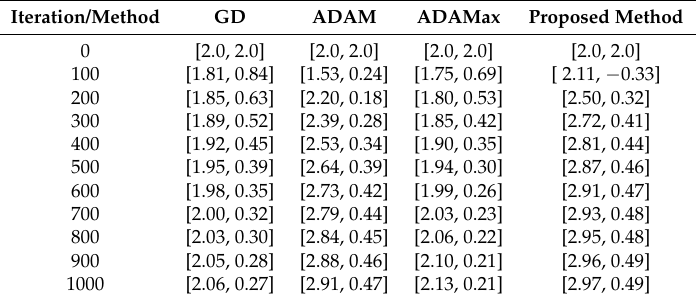
Table 1. Change of weights of each method.